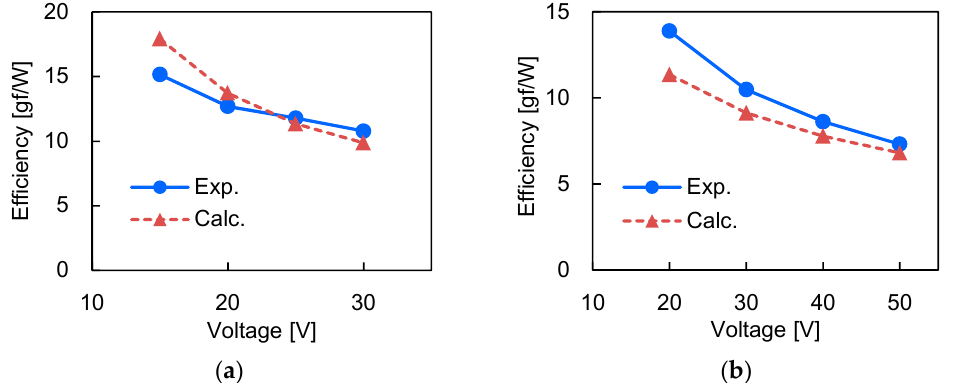
Figure 17. Relationship between applied voltage amplitude and lift-to-power efficiency: ( a ) small-type and ( b ) large-type actuators.